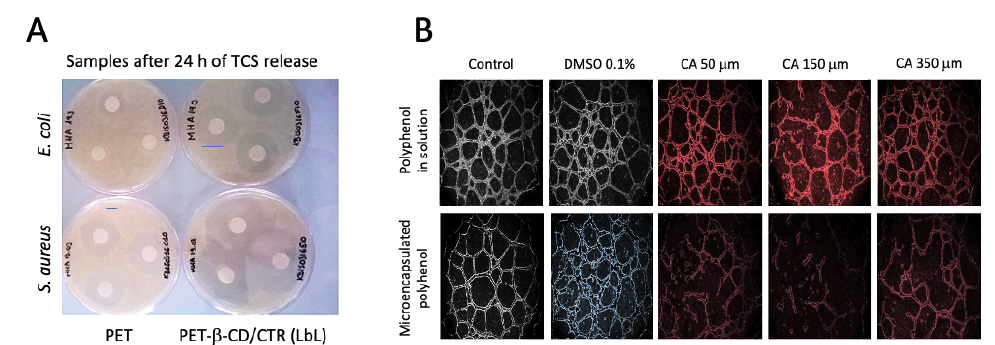
Figure 6. ( A ) Representative images of Kirby–Bauer test on TCS impregnated PET and PET- β - CD/CTR (LbL) samples against S. aureus and E. coli with inhibition zone after 24 h of TCS release in PBS at 37 °C. ( B ) Effect of treatment with caffeic acid in solution and loaded in the nPSi- β -CD/CTR microparticles on the ability of HUVECs to form tubular structures in Matrigel. Adapted from [70,73], with permission from Elsevier and MDPI,